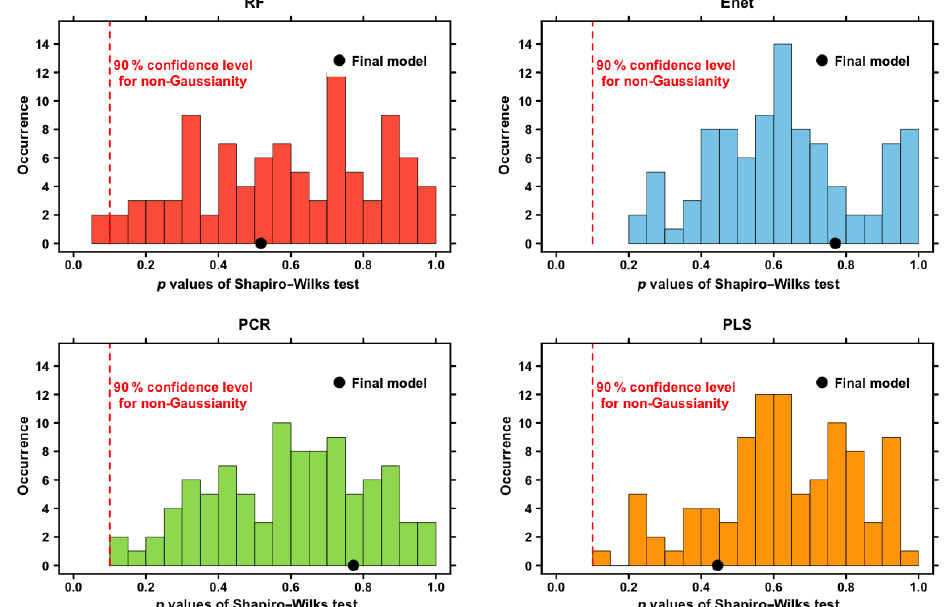
Figure 9. P values obtained from Shapiro–Wilk normality tests on the residuals from each reconstruction of Fig. 7. For panels (a) RF, (b) Enet, (c) PCR and (d) PLS, the repartition of the 50 p values obtained for each training/testing split is presented. Red dashed lines indicate the 90% confidence level for non-normality. For 0 ≤ α ≤ 1, if the p value ≤ α , it means that the residual distribution is significantly non- Gaussian at the 1 − α confidence level (see shapiro.test R documentation). Black dots indicate the p values of the residuals obtained for the final